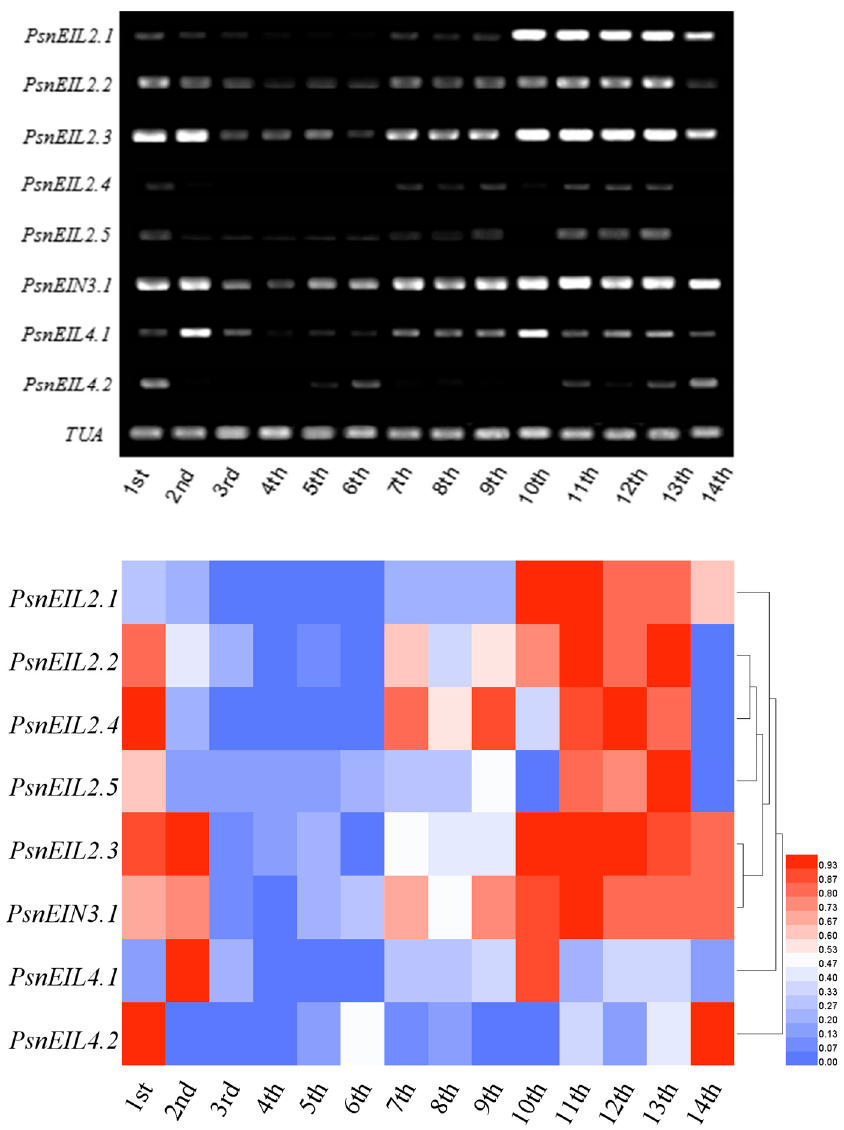
Figure 10. Relative PsnEIN3/EIL gene expression patterns in different leaves of Populus × xiaohei . Heat map showing the expression levels of PsnEIN3/EIL genes in different leaf developmental stages. The first leaf (1st) to the fourteenth leaf (14th) are presented in abbreviated form.